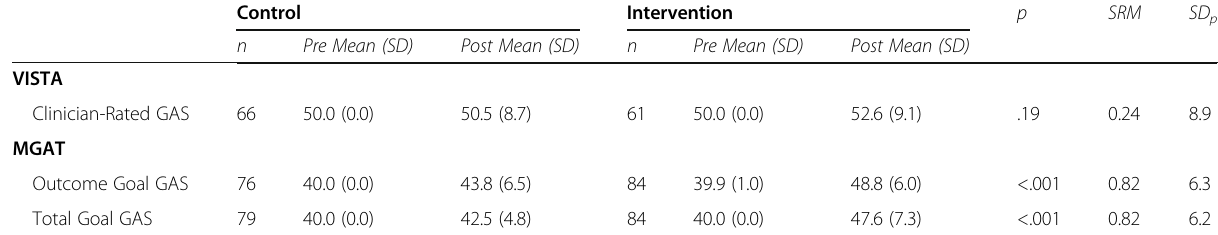
Table 5 One-Goal GAS sensitivity analysis a Control